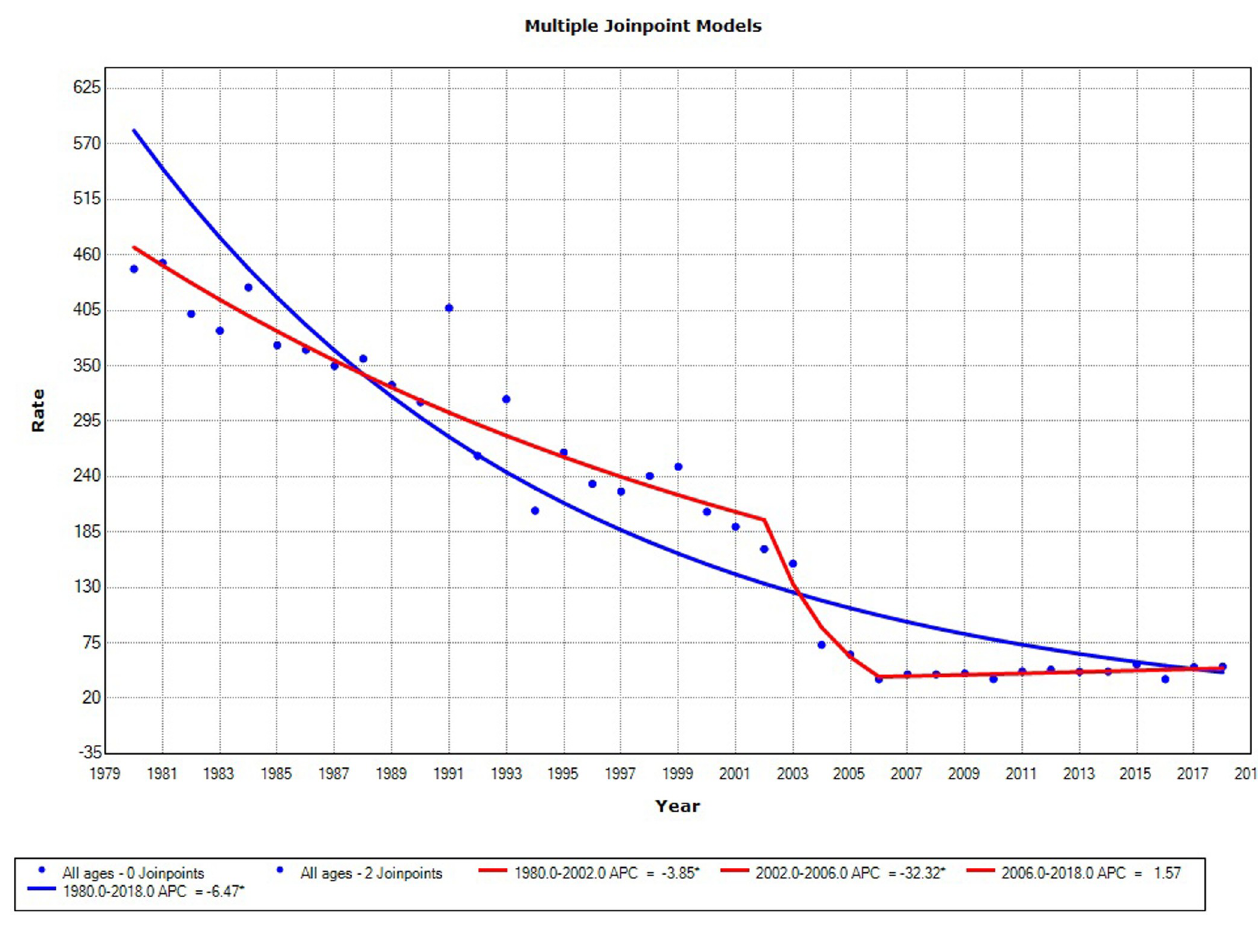
Fig 4. Mortality trends by ill-defined causes in males in Sergipe,